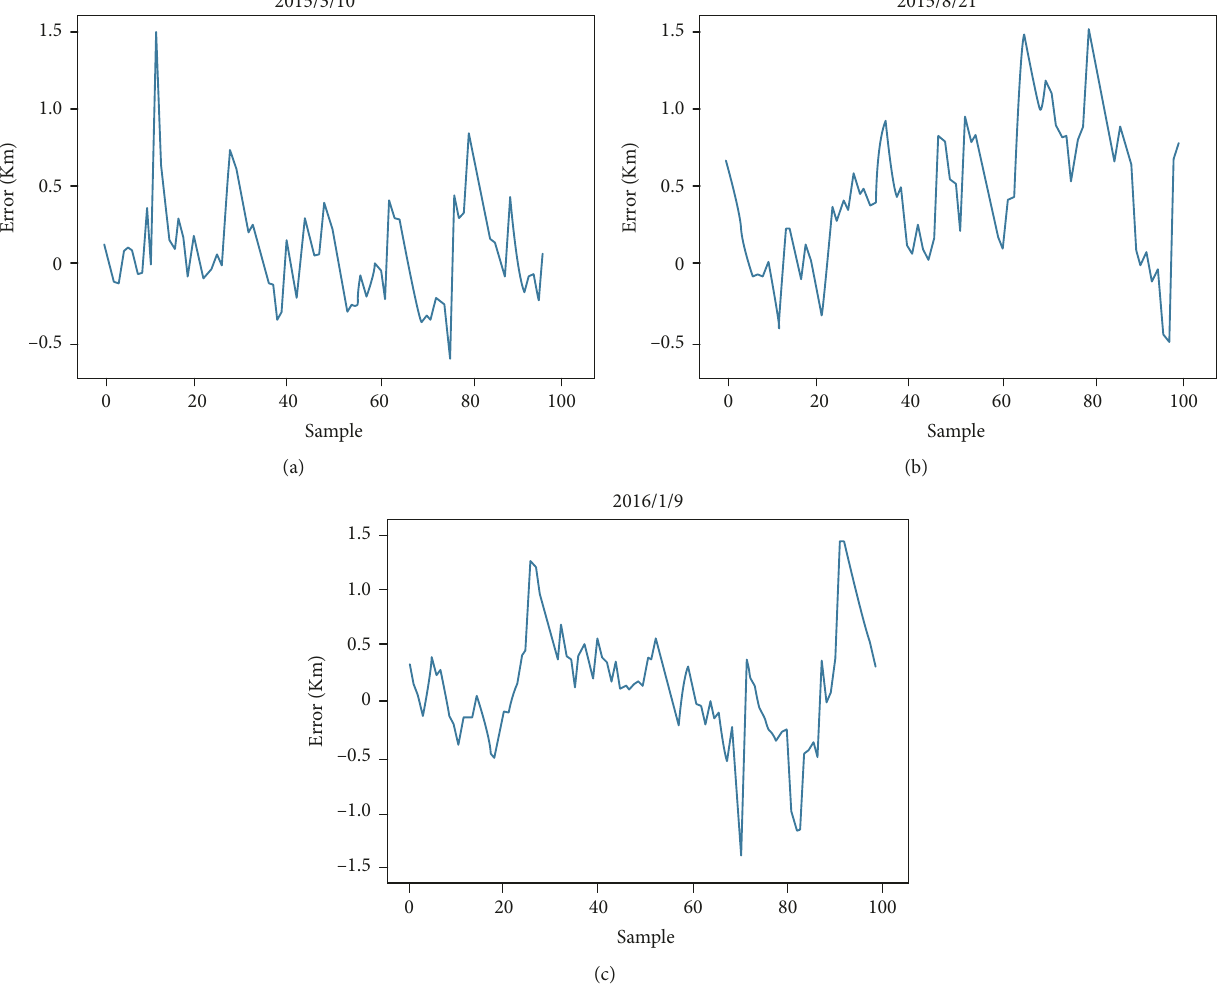
Figure 7: Residual error sequence chart of No. 12 BEV. Table 7: Comparison results of predictive